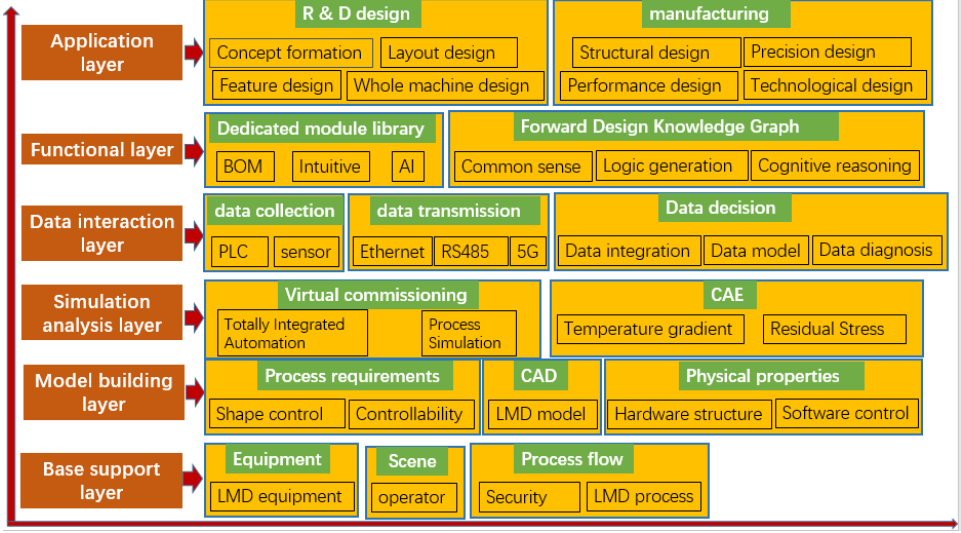
Figure 1. Digital twin system framework of LMD equipment.